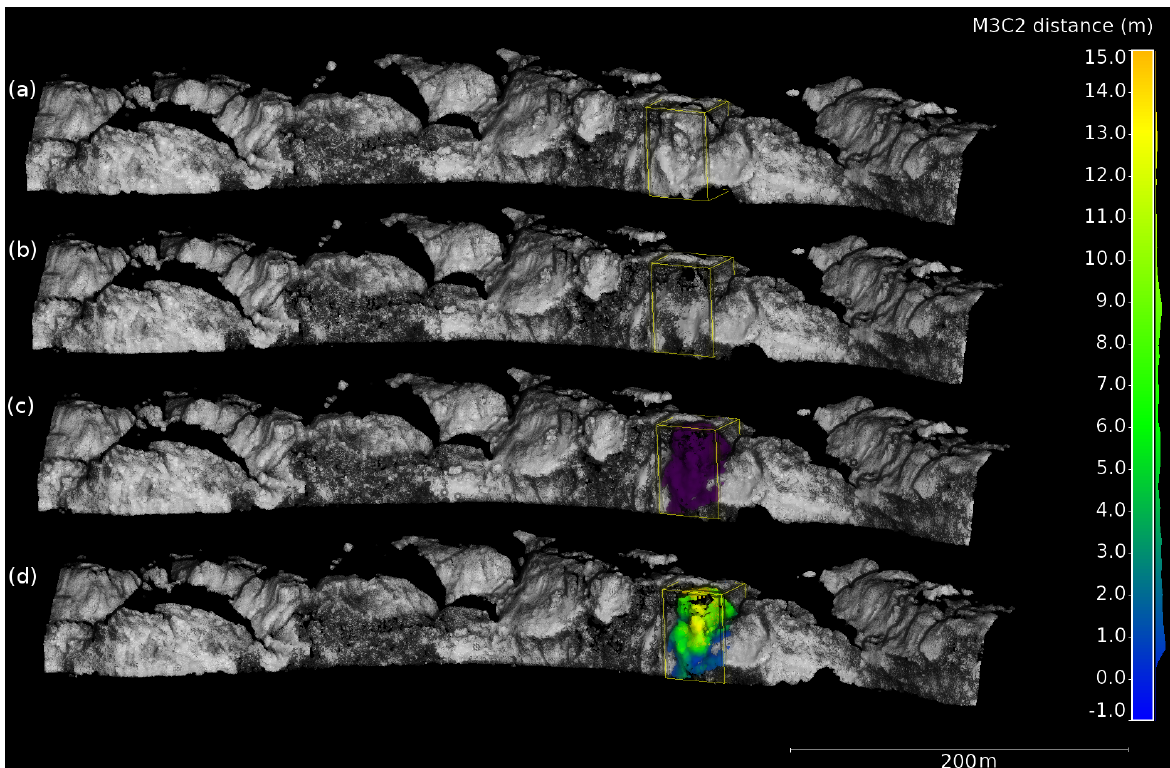
Figure B1. Lidar DSM differencing for a calving event on 2016-08-27T09:57:03 (a) point cloud before the event, (b) point cloud after the event, (c) area (purple) of the calving event, and (d) calving event depth computed with the M3C2 plugin (Lague et al., 2013). A histogram of computed depths is located to the right of the color bar, and the calculated calving event volume V is 7046 . 6 ± 632 . 3m 3 . The region of interest is marked with a yellow bounding box and the lidar reflection intensity is shown in grayscale on each point cloud (a–d)